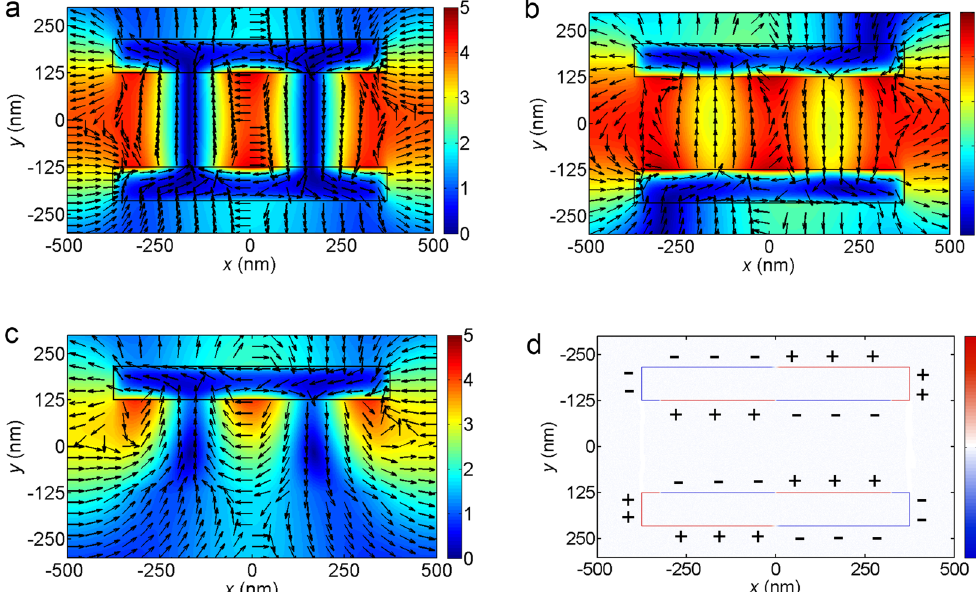
Figure 3. Plasmonic modes in the free-standing MDM stack array and single layer metallic grating. ( a ) Calculated magnetic field intensity | H z | (color map), electric displacement (arrow map), and ( d ) charge distribution at the transmission peak 1462 nm under normal incidence. ( b ) Calculated magnetic field intensity | H z | and electric displacement at the transmission peak 1412 nm with incident angle 15°. ( c ) Calculated magnetic field intensity | H z | and electric displacement at the transmission peak 1398 nm under normal incidence. ( a , b , d ) free-standing MDM stack array, ( c ) free-standing single metallic